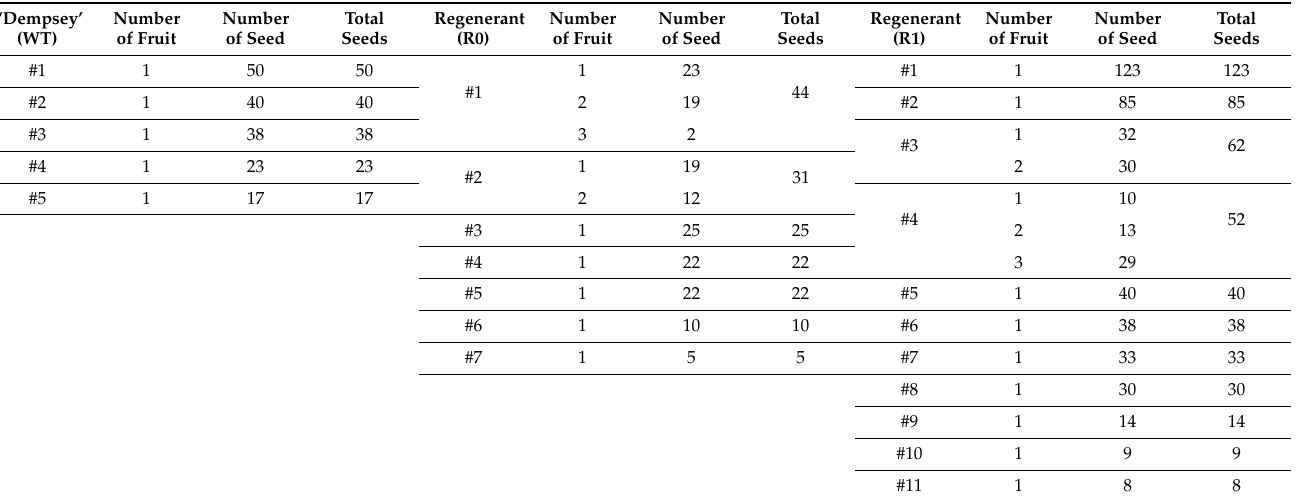
Table 2. Summary of ‘Dempsey’ pepper fruit and seed numbers, including those of its regenerants and their progenies. ‘Dempsey’ Number (WT) of